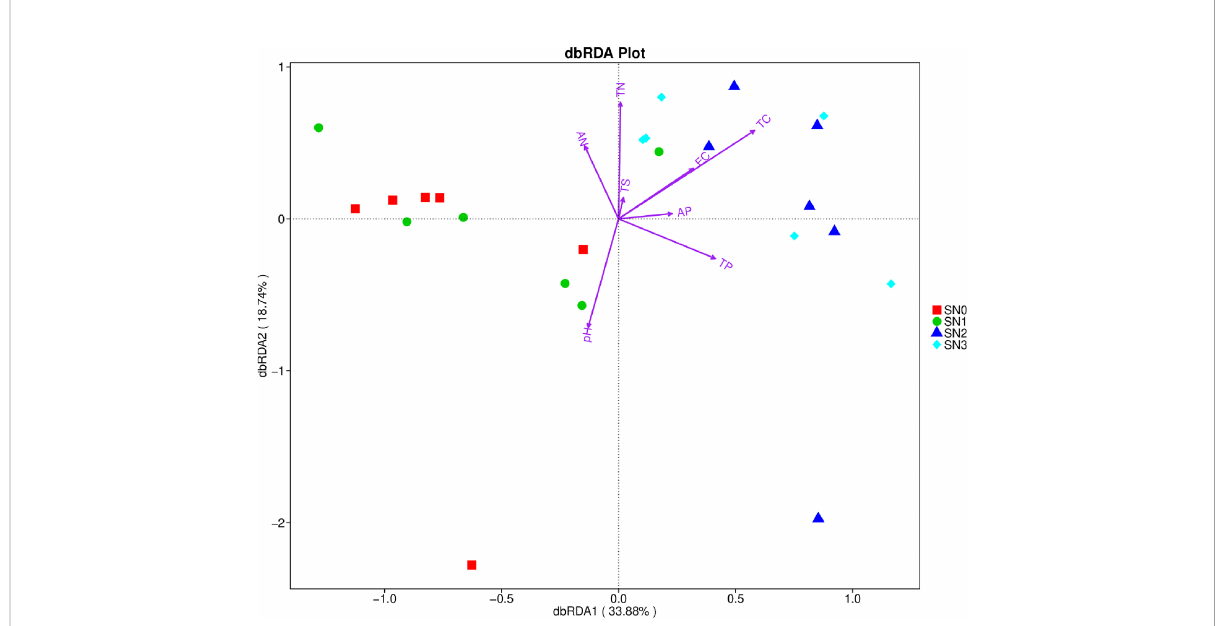
FIGURE 2 The distance-based redundancy analysis (dbRDA) plot. The relationship of soil physical and chemical properties and bacterial OTUs composition. SN0 is N0 in September 2018, SN1 denotes N1 in September 2018, SN2 means N2 in September 2018 and SN3 indicates N3 in September 2018. AN, soil available N; TN, soil total N; EC, electrical conductivity; TC, soil total N; AP, Soil available P; TP, soil total P; TS, soil total